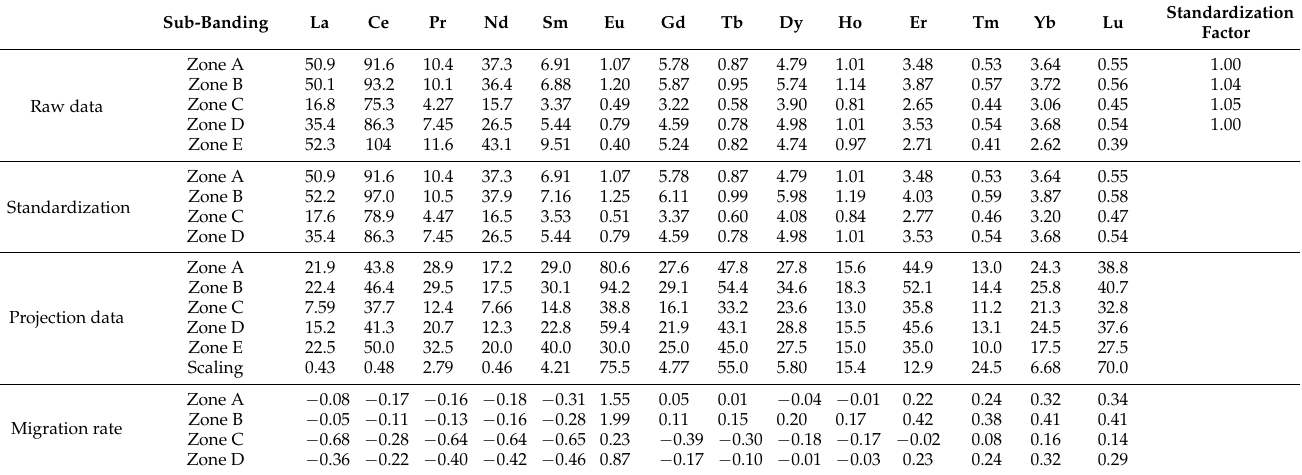
Table 3. Rare element content ( × 10 − 6 ) and data processing results of ore-fresh rock zoning rocks in the Zhangjiawu uranium deposit, Zhejiang Province,